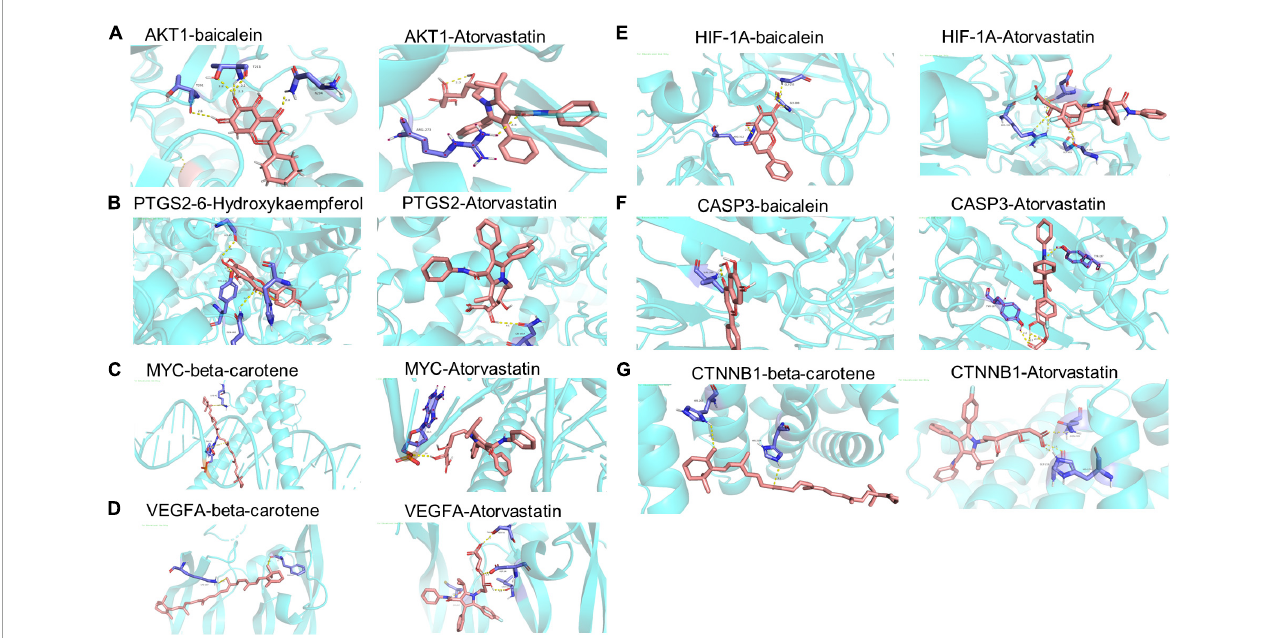
FIGURE8 Molecular dockings of the 8 core targets and their corresponding ingredients. (A) AKT1 and baicalein ( − 10.1 kcal.Mol), AKT1 and Atorvastatin ( − 10.2 kcal.Mol). (B) PTGS2 and 6-Hydroxykaempferol ( − 9.3 kcal.Mol), PTGS2 and Atorvastatin ( − 8.5 kcal.Mol). (C) MYC and beta-carotene ( − 7.8 kcal.Mol), MYC and Atorvastatin ( − 8.4 kcal.Mol). (D) VEGFA and beta-carotene ( − 7.9 kcal.Mol), VEGFA and Atorvastatin ( − 6.7 kcal.Mol). (E) HIF-1A and baicalein ( − 8.6 kcal.Mol), HIF-1A and Atorvastatin ( − 7.2 kcal.Mol). (F) CASP3 and baicalein ( − 7.5 kcal.Mol), CASP3 and Atorvastatin ( − 8.7 kcal.Mol). (G) CTNNB1 and